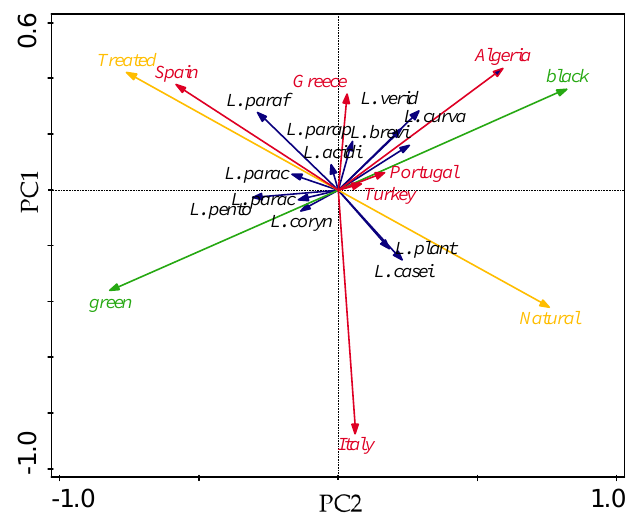
Figure 5. Plot of loadings formed by principle component analysis. LAB, country, color, and method type are represented in black, red, green, and yellow, respectively. A plot of scores is conveyed in Figure 6, where seven clusters can be pinpointed. On the top-left side, L. parafarraginis was reported only for Spanish-treated green olives from the Manzanilla cultivar (see Table 2). On the top-right side, L. brevis , L. curvatus , and L. veridesens were typically associated with Algerian natural black olives, despite belonging to different cultivars (Chemlal, Hamra, and Sigoise). Additionally, L. plantarum and L. pentosus were found in the remaining five clusters; this means that such species are present in all types of olive cultivars reported, irrespective of country, processing method, or olive color. Finally, two clusters are apparent on the lower-left side; L. casei was typically found in natural processes with Italian green or black olives and Algerian black olives.